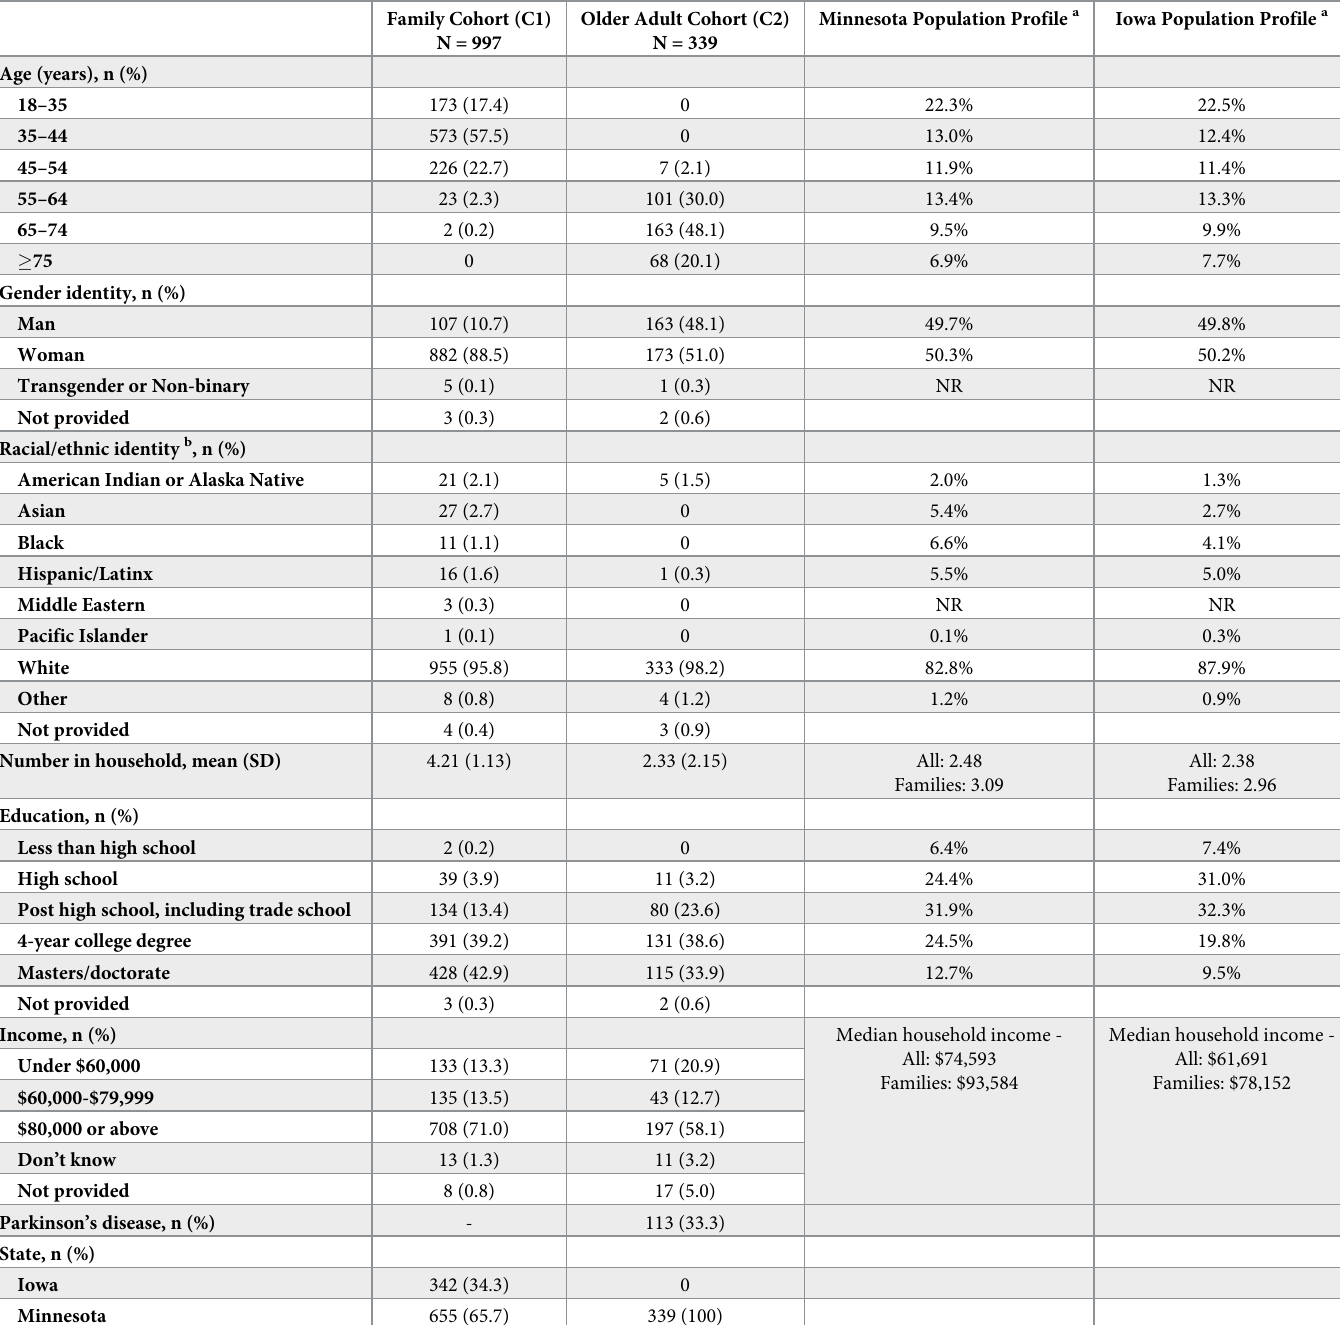
Table 1. Participant characteristics by study cohort, with source state population profiles provided for